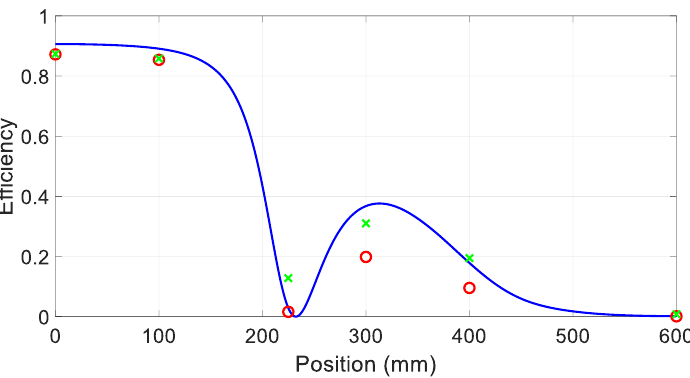
Figure 10. Power transfer efficiency obtained from FEM (red circle) and efficiency computed considering together the losses and the load power obtained from FEM (green stars) and by computation of the independent circuit (blue line).